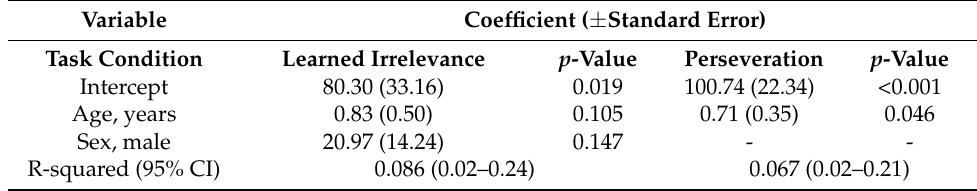
Table 2. Summary of multivariable linear regression models to predict the rate of change in reaction time after the incompatible stimulus. Model selection was performed using stepwise selection with the Akaike information criterion. 95% confidence intervals (CI) for R2 values were calculated using a bootstrap with 10,000